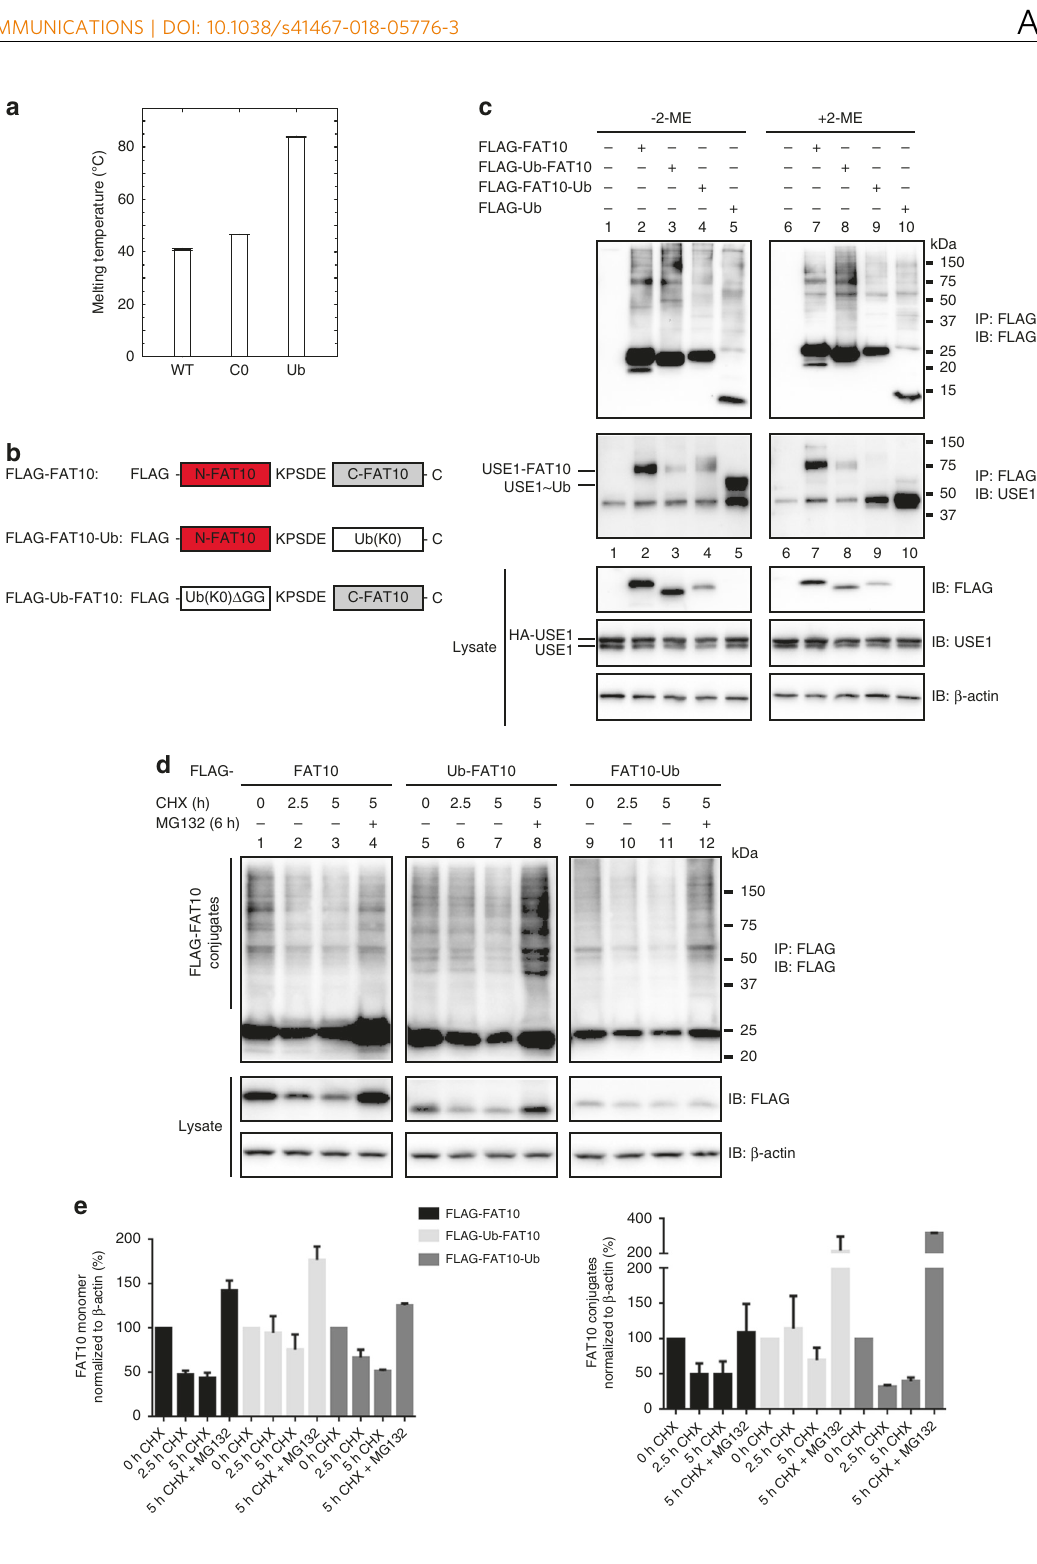
its conjugates were degraded much slower than WT FAT10 and its conjugates (Fig. 5a, b). To gain insight into the role of the four FAT10 Cys residues in protein stability we performed molecular dynamics (MD) simulations of the WT and Cys-free FAT10 N- and C-domains (Fig. 5c). We observed that in general the structures of both the